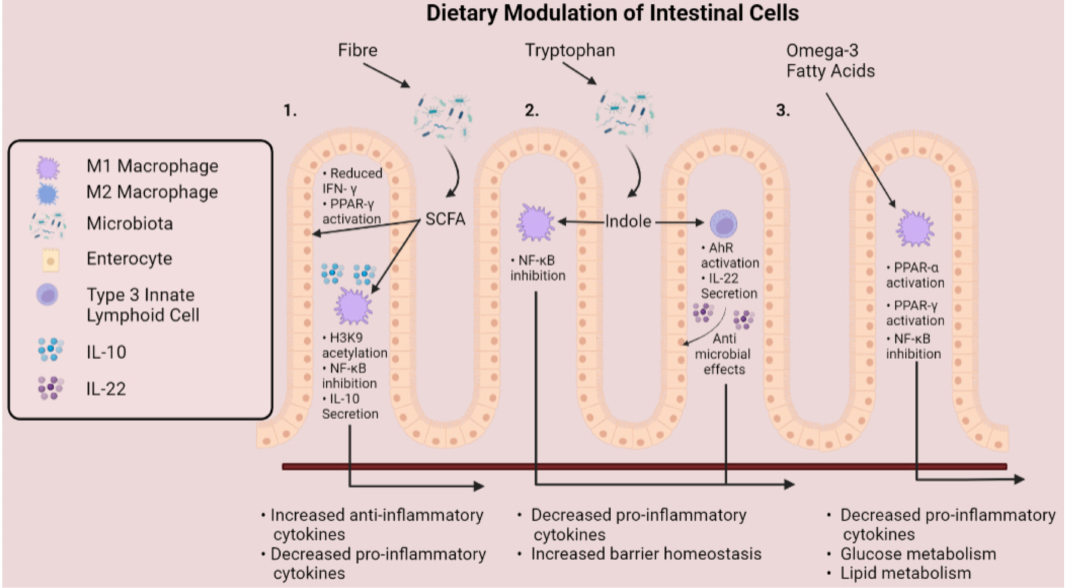
Figure 4. Mechanisms that dietary metabolites modulate cells of the gastrointestinal tract. Fibre and tryptophan are metabolised by the microbiota to release short-chain fatty acids and indole compounds into the gut lumen. ( 1 ). Short-chain fatty acids enhance PPAR- γ activation and reduce IFN- γ production of intestinal epithelial cells, while inducing immunomodulatory effects on intestinal macrophages. ( 2 ). Indole suppresses activation of NF-kB and stimulates production of IL-22 by group 3 innate lymphoid cells, promoting epithelial barrier homeostasis. ( 3 ) Omega-3 polyunsaturated fats promote an anti-inflammatory macrophage phenotype through activation of PPAR- α and PPAR- γ , along with inhibition of NF- κ B, culminating as decreased production of pro-inflammatory